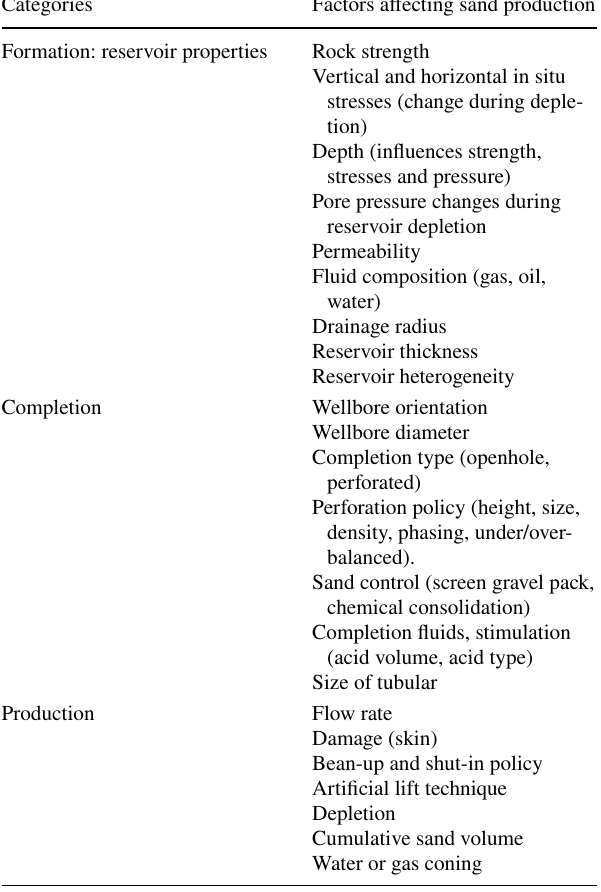
Table 1 Parameters influencing sand production (Khamehchi